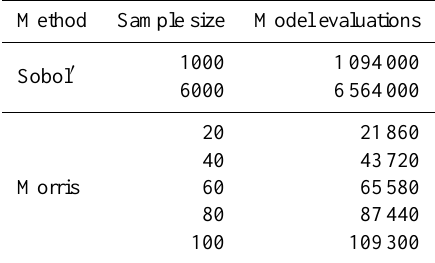
Table 1. Sample sizes and number of model runs performed for each of the sensitivity analysis